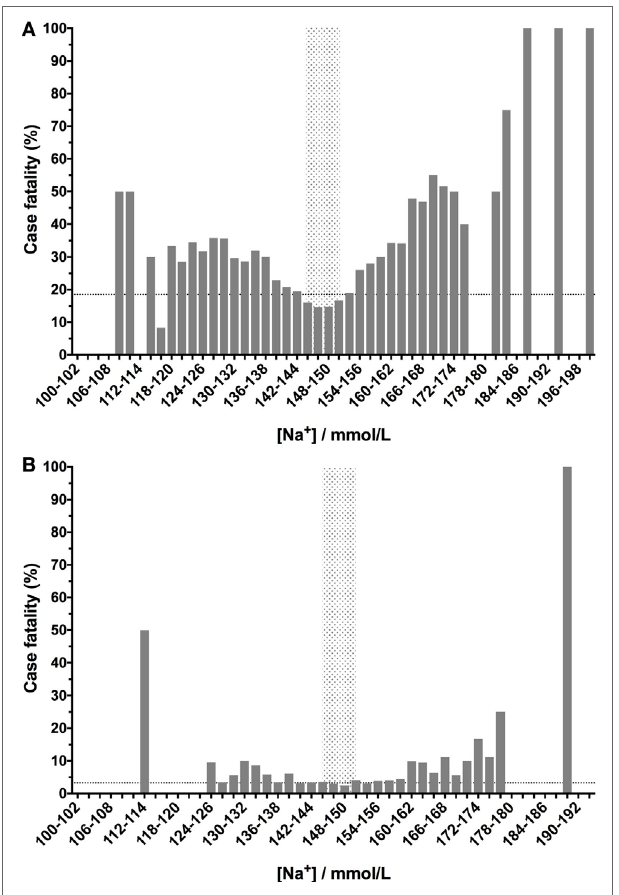
FigUre 2 | Canine corrected blood chloride concentrations have a U-shaped relationship with case fatality rates. Chloride values were corrected for sodium concentrations as follows: [Cl − ] Corrected = [Na + ] Normal / [Na + ] Measured × [Cl − ] Measured . Low- or high-corrected chloride concentrations are associated with increased case fatality rates. Corrected chloride values were banded into 2 mmol/L bins, and the percentage case fatality for the patients in each of these subgroups was calculated. The dotted lines denote the case fatality rate across the entire data set (the background case fatality rate). Panel (a) represents data from all samples ( n = 33,117), including those from patients that were euthanized, while panel (b) represents data from patients that survived or died only (i.e., euthanized patients were excluded) ( n = 27,904).